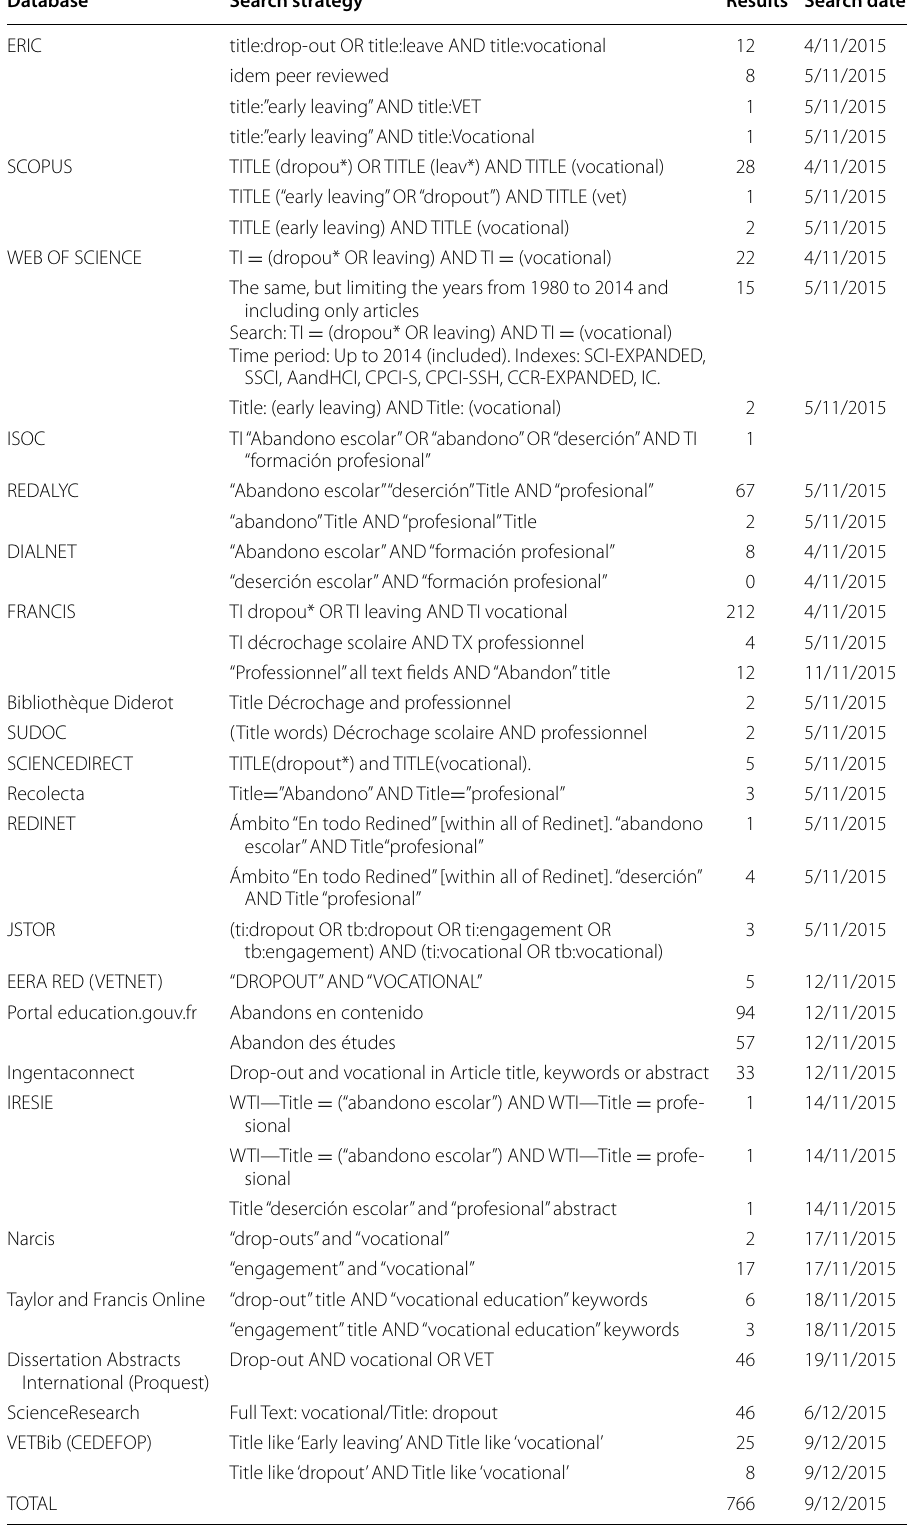
Table 1 Databases queried, search strategy used for each one, and